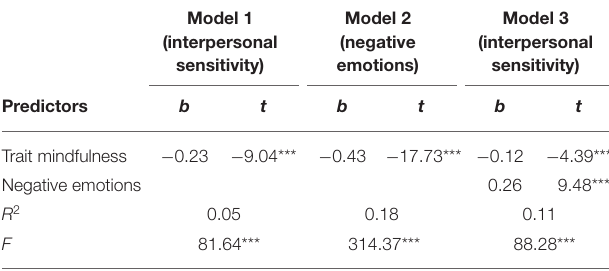
TABLE 2 | Testing the mediation effect of mindfulness on interpersonal